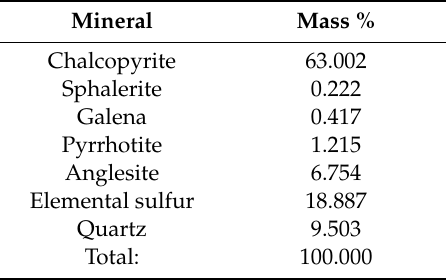
Table 4. Mineral composition of leach residue.